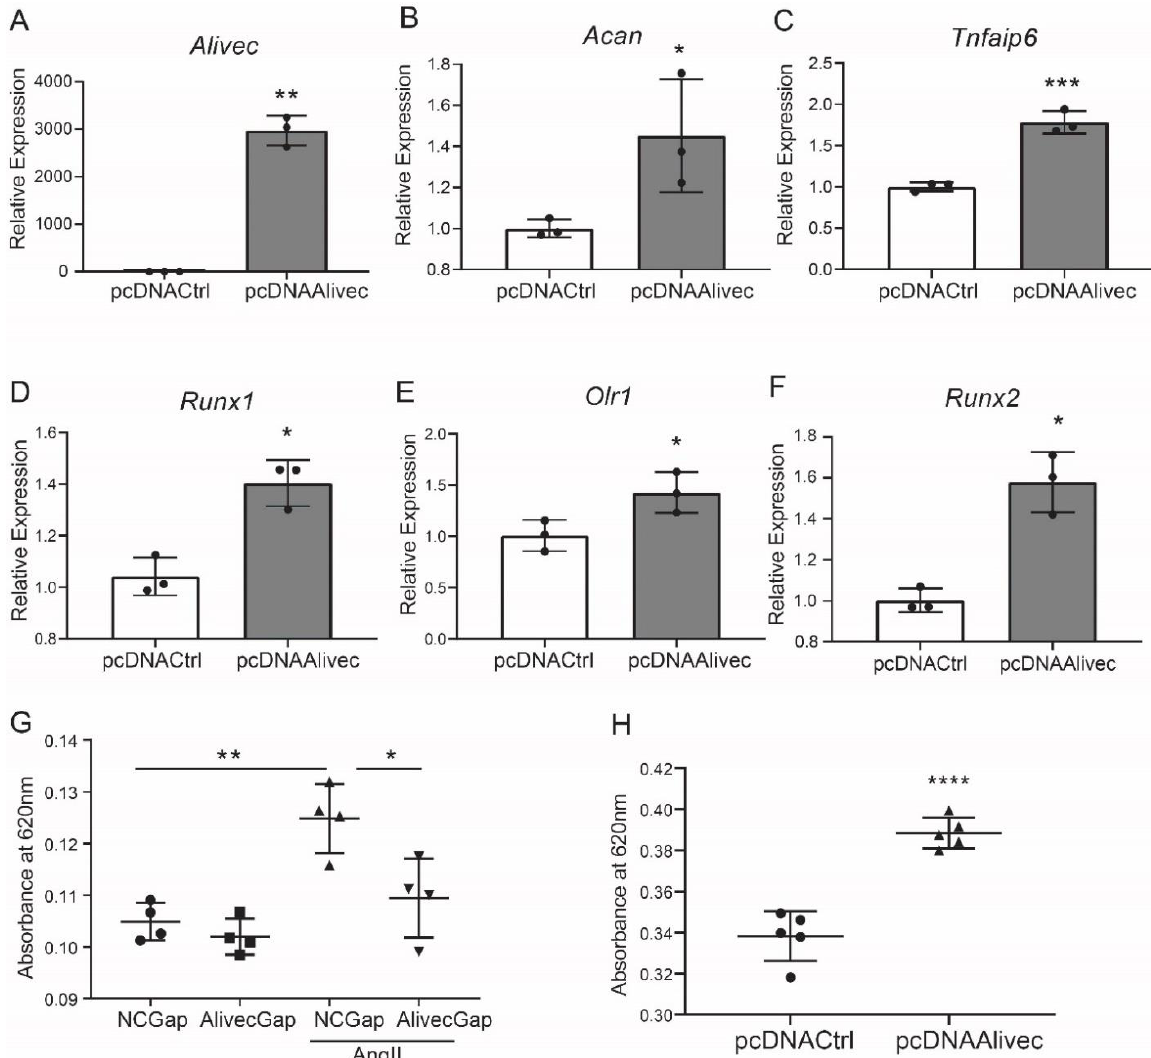
Figure 4. Alivec overexpression promotes and its knockdown inhibits the chondrogenic/osteogenic phenotype in RVSMCs. ( A ) RT-qPCR analysis showing expression of Alivec after transfection of RVSMC with pcDNAAlivec vs. empty vector (pcDNACtrl). ( B – F ) RT-qPCR analysis showing expression of target genes Acan , Tnfaip6 , Runx1 , Olr1 and Spp1 after overexpression of Alivec in RVSMCs. Data presented as mean ± SD, n = 3 biological replicates, unpaired two-tailed Student’s t -test and * p < 0.05, ** p < 0.01, *** p < 0.001 vs. pcDNACtrl. ( G ) Alcian blue staining performed on RVSMCs transfected with NCGap and Alivec Gap and treated ± AngII (100 nM). Data were presented as mean ± SD, n = 4 biological replicates, one-way ANOVA followed by Tukey’s post-hoc correction and * p < 0.05, ** p < 0.01 vs. indicated groups. ( H ). Alcian blue staining after overexpression of Alivec in RVSMCs. Data presented as mean ± SD, n = 5 biological replicates, unpaired two-tailed Student’s t -test and **** p < 0.0001 vs.